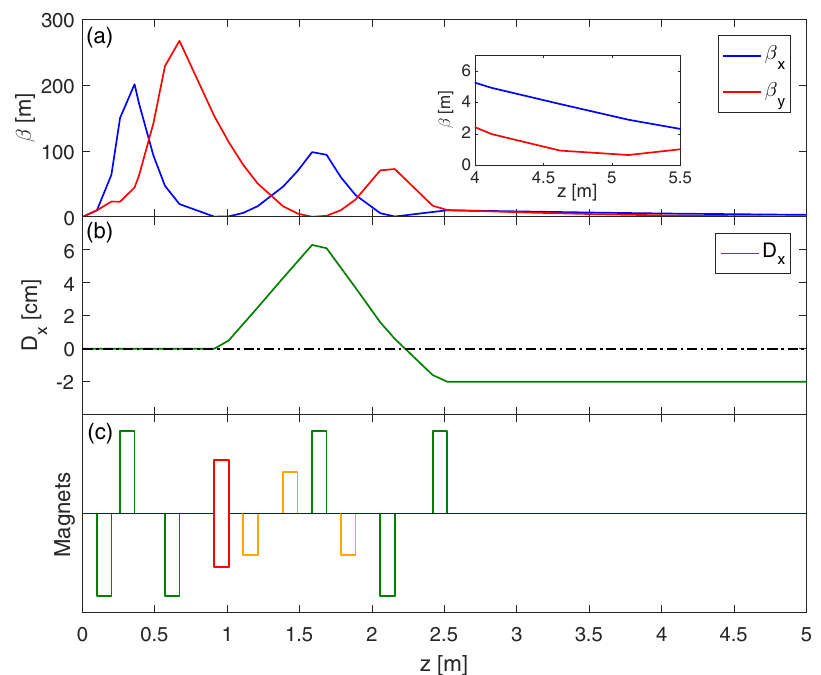
FIG. 2. Beta functions (a) and dispersion function (b) of the reference energy along the beam line. (c) Layout of the beam transport system including one dipole (red), six quadrupoles (green) and three sextupoles (orange). After the position of z ¼ 2 . 7 m, the drift space is used for the TGU radiation.